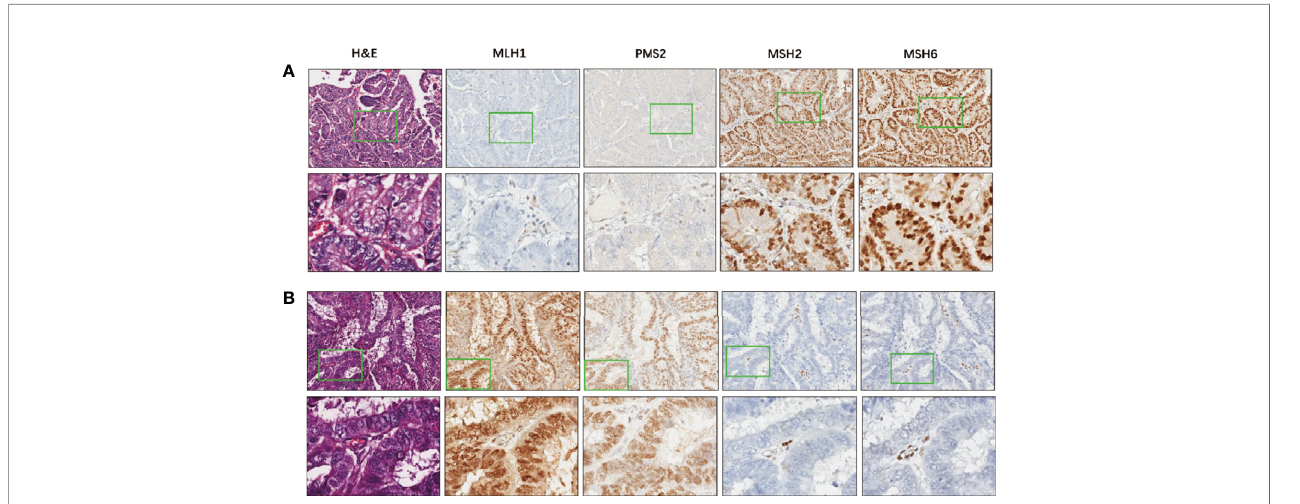
FIGURE 1 | Examples of MMR de fi ciency in endometrial cancer. (A) A representative case that harbors de fi ciency in MLH1 and PMS2, but pro fi cient in MSH2 and MSH6. Images in the bottom show details of the areas indicated by green boxes in the images above. Magni fi cation: 5× (top) and 200× (bottom). (B) A representative case that de fi cient in MSH2 and MSH6, but pro fi cient in MLH1 and PMS2. Images in the bottom show higher magni fi cation of the areas indicated by green boxes in the images above. Magni fi cation: 5× (top) and 200×